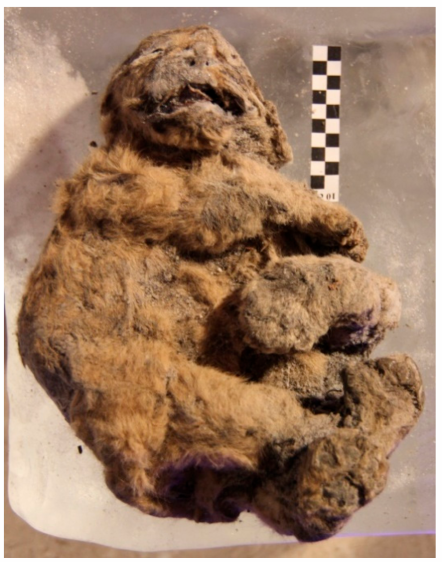
Figure 7. Frozen mummy of the cave lion cub named Uyan, Uyandina River, Yakutia. The guard hair on the muzzle of both cave lion pups has brown tips. There are dark spots on the forehead and above the eyes (Figure 6c). The fur is lighter around the eyes, but brown near the corners of the mouth. There are dark reddish-brown spots on the backside of Sparta’s ear conches, while Boris has black spots on his ear conches (Figure 6d), much similar to the contemporary P. leo